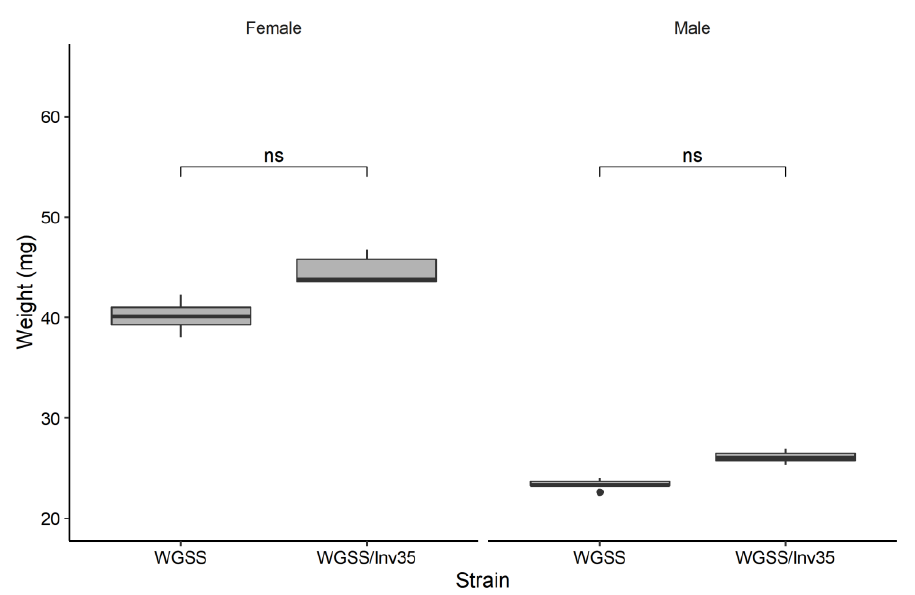
Figure 6. Weight per 10 male and female pupae of WGSS and WGSS/Inv35 strains. Three replicates were performed per sex per strain. Statistical analysis was carried out using a GLM with Poisson distribution. The whiskers indicate the variability outside the upper and lower quartiles (repre- sented as the upper and lower boxes, respectively). The thick horizontal line represents the median, and the dot indicates a possible outlier. Significance symbol: ‘ns’ for ‘not significant’.